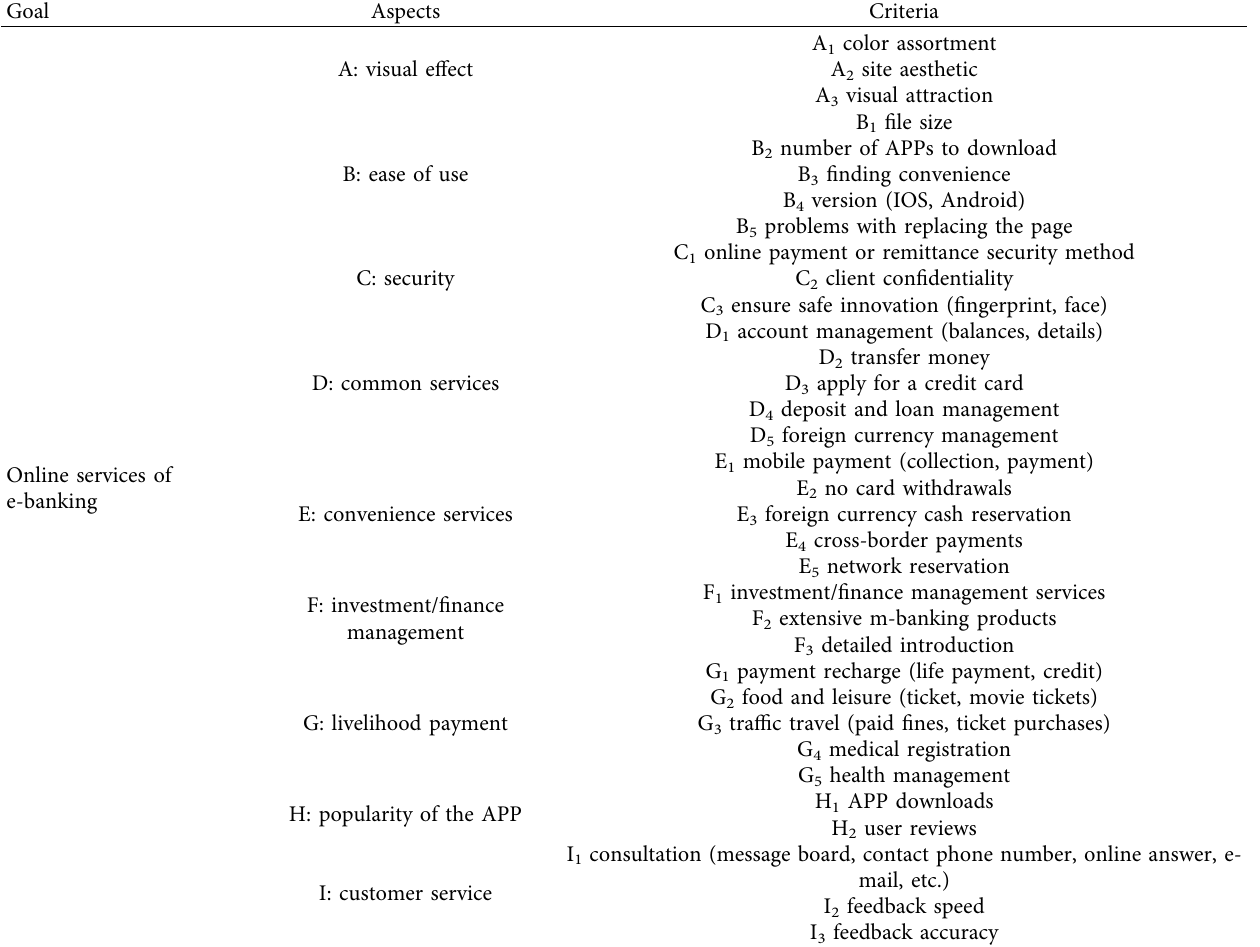
Table 14: The measures of the online services of mobile banking.